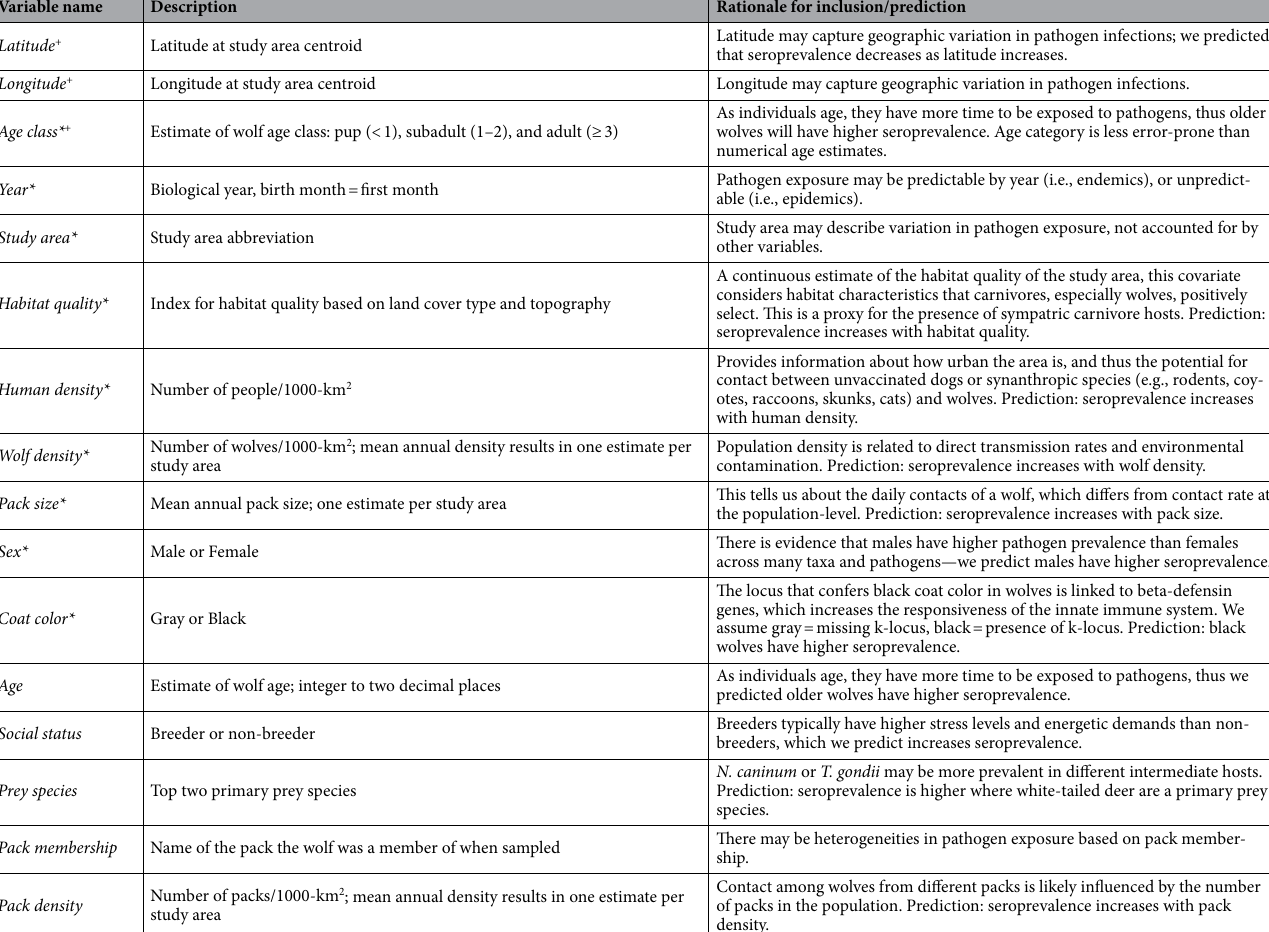
Table 2. A list of variables considered for inclusion in generalized linear mixed models predicting pathogen and parasite exposure. Variable descriptions and rationales or predictions are provided; a * indicates the variable was included in the final complete model , a + indicates the variable was included in the geographic